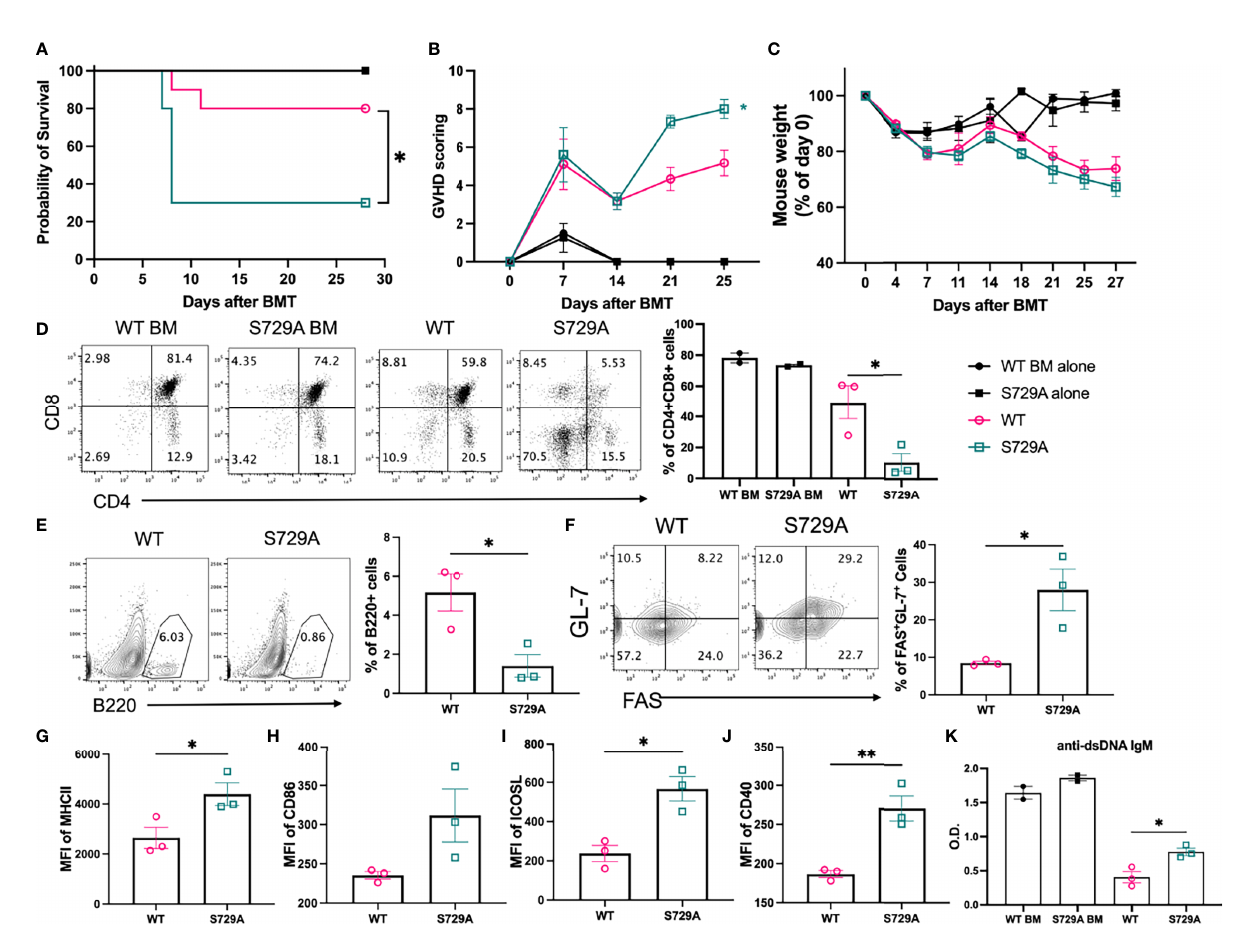
FIGURE 7 | Effect of S729A mutation on B cell activation and cGVHD pathogenicity. BALB/c mice were lethally irradiated and transplanted with 5 x 10 6 TCD-BM cells from WT and S729A mice on a B6 background with (n = 10) or without (n = 4) 0.12 x 10 6 B cells from WT or S729A mice and 0.18 x 10 6 B cell deleted WT splenocyte. Survival (A) , GVHD score (B) and mouse weight (C) were monitored during the experiment. Subsets of recipient mice were euthanized on day 28, and thymi and spleens were dissected and processed into single-cell suspension. CD4 and CD8 double positive cell percentages in thymus were determined using fl ow cytometry (D) . The percentages of B220 + B cells (E) , germinal center B cells (FAS + GL-7 + ) (F) , the expression of MHCII (G) , CD86 (H) , ICOSL (I) , and CD40 (J) were detected by fl ow cytometry analysis. Serum isolated from recipients was collected on day 28 and assayed for anti-dsDNA autoantibodies using ELISA (K) . (A – C) shows combined data from two independently repeated experiments. (D – K) shows representative data from two independently repeated experiments. 14 recipient mice were used for each experiment. Comparison of the survival distributions in (A) was done using log-rank test. Statistics were performed using two-way ANOVA with Tukey ’ s multiple comparison test for (B, C) One-way ANOVA with Tukey ’ s multiple comparison test was used for comparing multiple groups and 2- tailed Student t test was used for comparing between two groups. *p < 0.05, **p < 0.005, and ****p < 0.0001 when compared to WT. # p < 0.05, ## p < 0.005, ### p < 0.0005, and #### p < 0.0001 when compared to XBP-1 KO